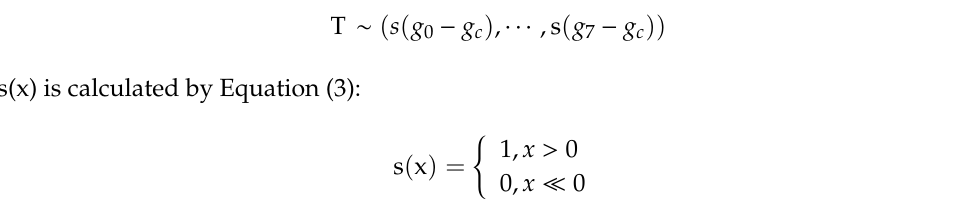
Figure 6. Complete process of the local binary pattern